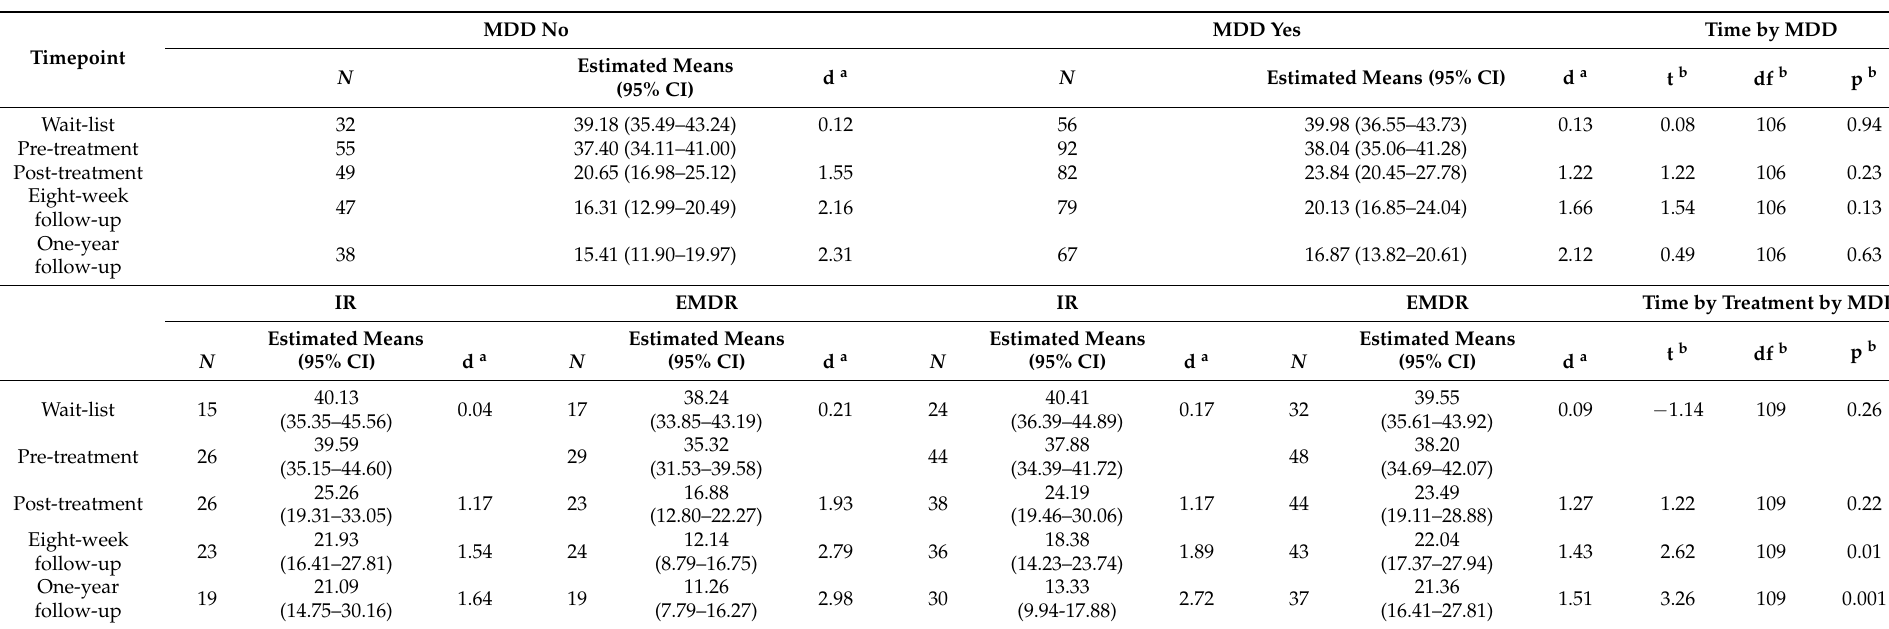
Table 2. Primary treatment outcome CAPS-5 by MDD diagnosis and treatment condition across all assessment